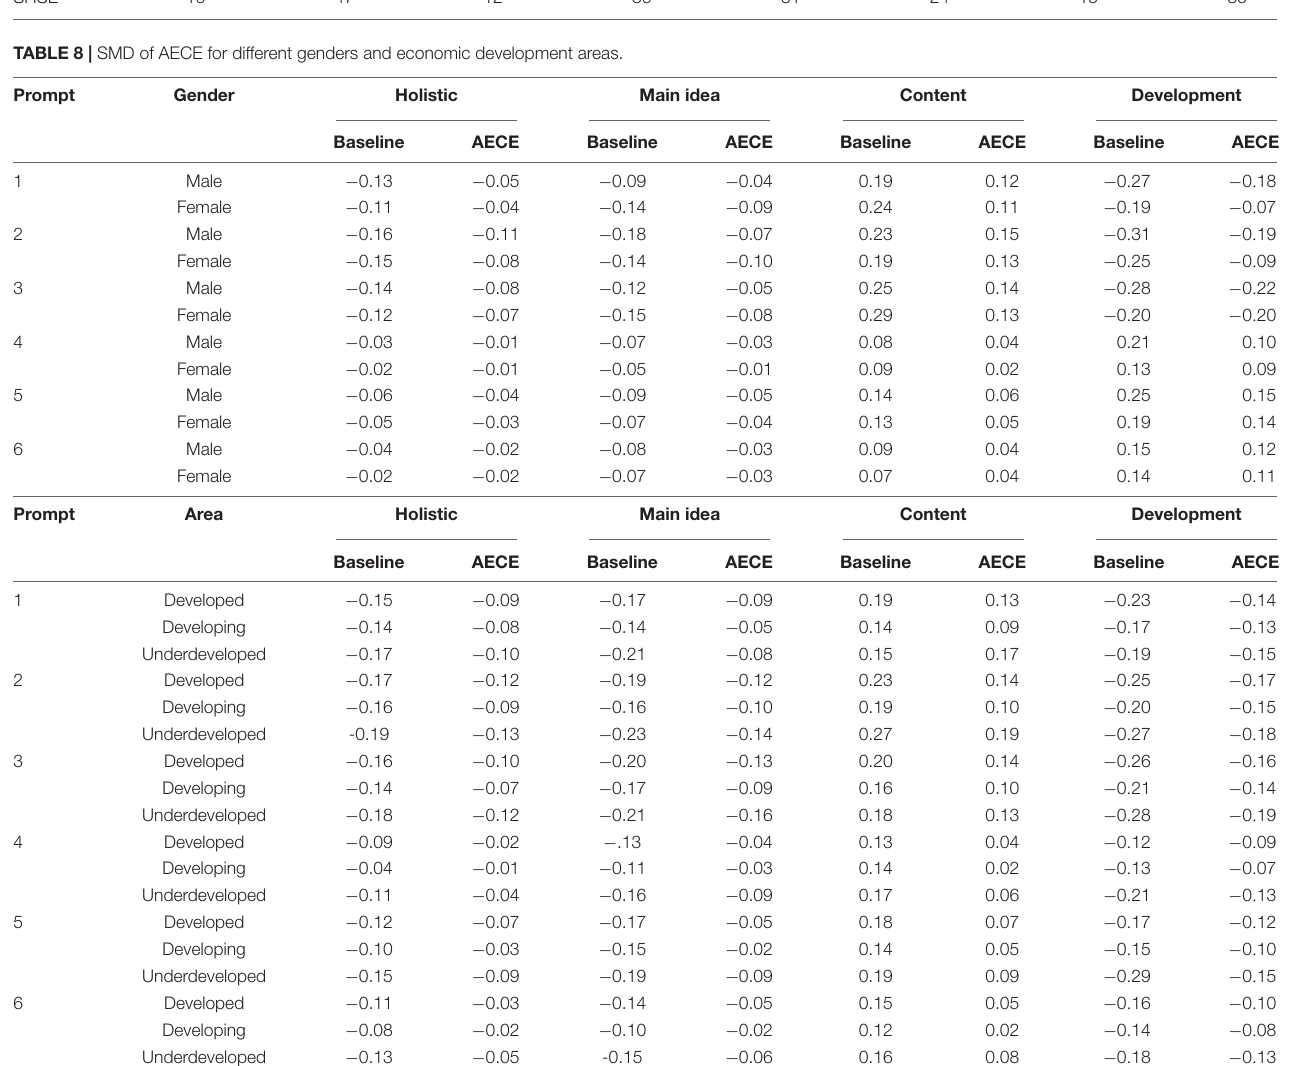
TABLE 8 | SMD of AECE for different genders and economic development areas. Prompt Gender Holistic Main idea